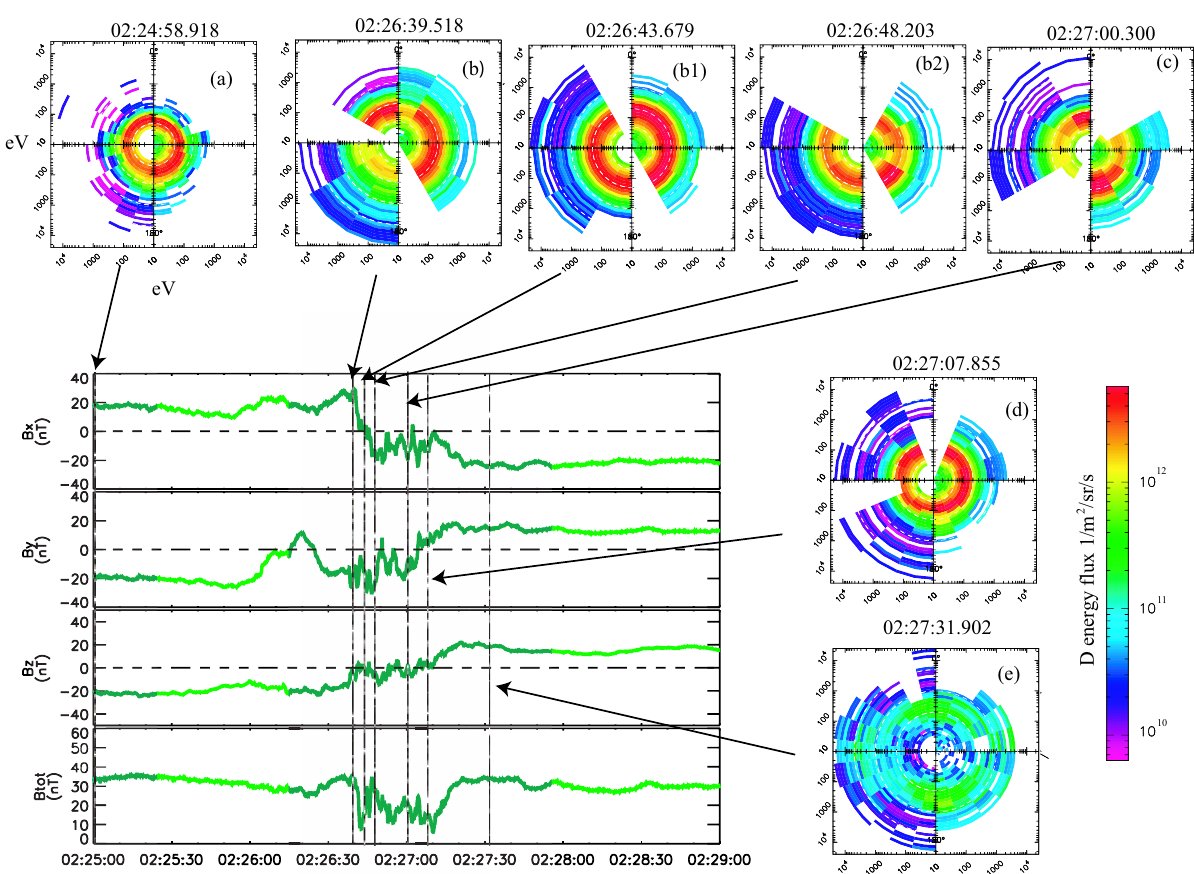
Fig. 11. Electron velocity distribution function during an interval of the second type boundary crossing with large magnetic